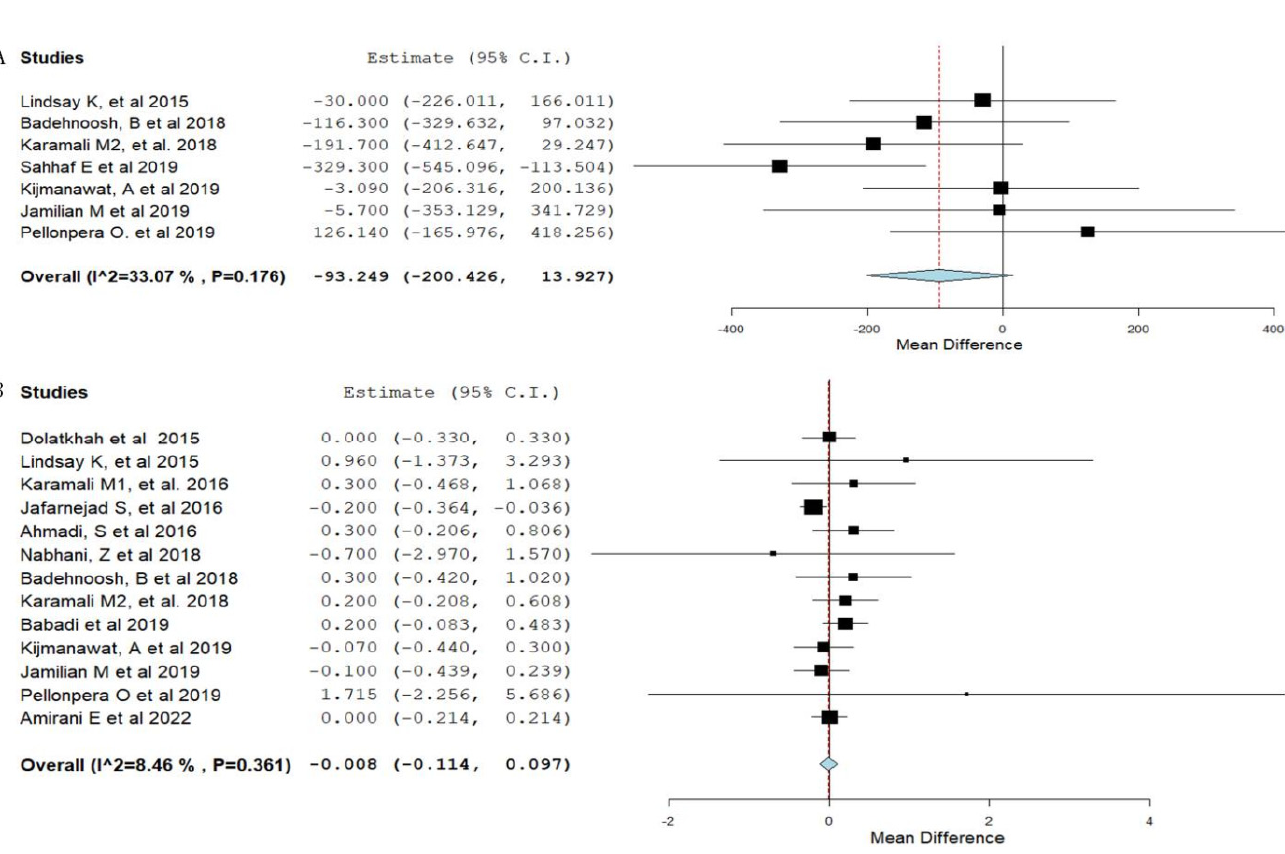
Figure 5. Forest plot of probiotic treatment versus placebo and neonatal birth weight (g) ( A ) and maternal weight gain (kg) [23,24,27,29–31,34] ( B ) C.I.: confidence interval [12,14,22,24–31,34,35].